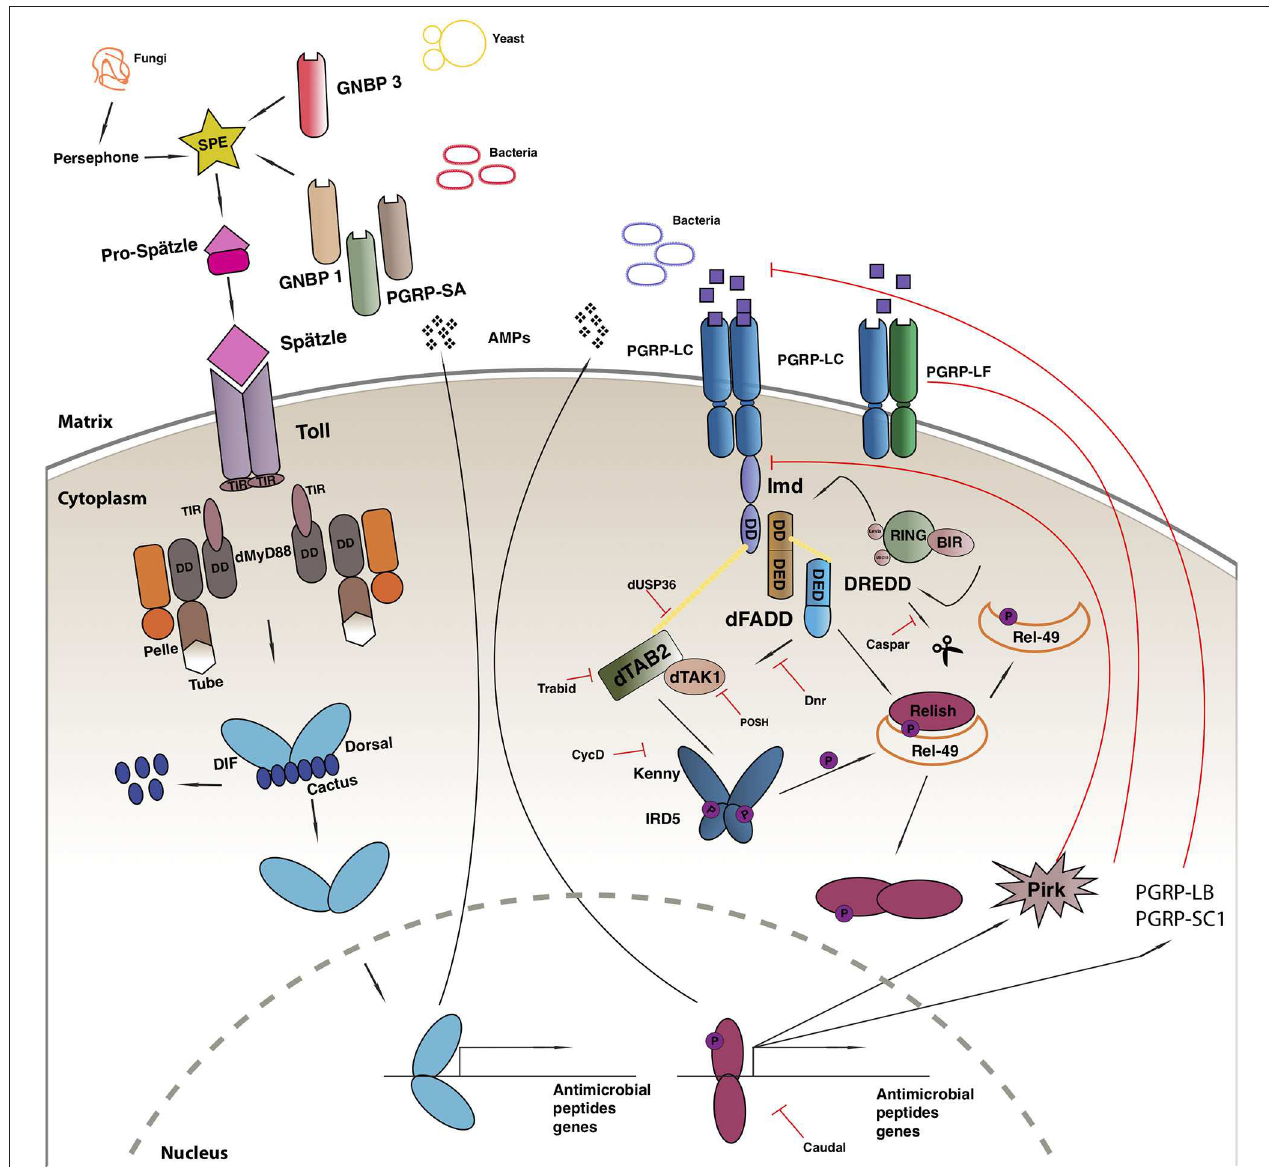
FIGURE 1 | Drosophila immune response. Toll pathway (on left) and IMD pathway (on right). See main text for details to the legend.